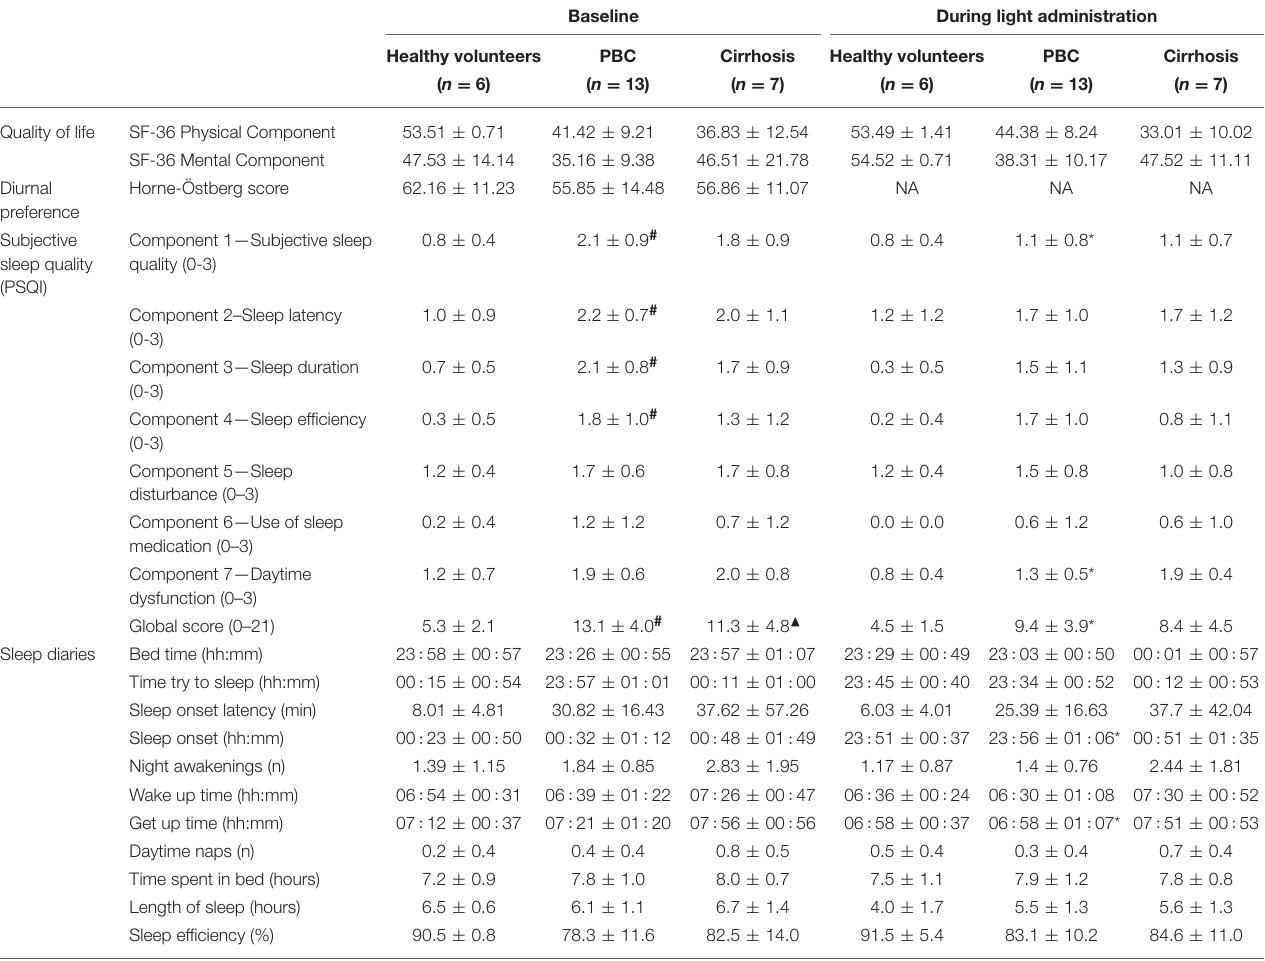
TABLE 1 | Quality of life, diurnal preference questionnaire, sleep questionnaire, and sleep diary variables (mean ± SD), by group and in relation to treatment. Baseline During light administration